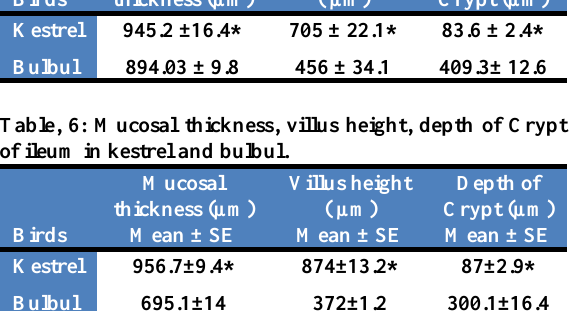
Table, 3: Mucosal thickness, villus height, depth of Crypt of duodenum in kestrel and bulbul. Depth of Figure, 5: Section of villus (kestrel). Micrograph (A) shows: Goblet cells (G), lamina propria (P), Nucleus of epithelial cells (Black arrow), and nuclus of fibrocyte (Red arrow). H&E stain, 400X. Micrograph (B) shows: Goblet cells (G), Red blood cells (RBCs), Nuclus (N), and brush border (arrows). H and E stain. 1000X. Table, 4: Ratio of goblet cells number pear 100 epithelial cells in villus in duodenum, jejunum, ileum of kestrel and bulbul. Birds Bulbul % Kestrel % Intestinal segment 28% 24% Duodenum 41% 28% Jejunum 50% 47% Ileum The numbers represent the mean ± standard error. *= There was a statistically significant difference between the two bird (P = <0.01). Table, 5: Mucosal thickness, villus height, depth of Crypt of jejunum in kestrel and bulbul. Figure, 6: Section of duodenum (white eared bulbul) shows: Villus (1), tunica muscularis (2), tunica serosa (3) lamina propria (P) and branches of villi (Red arrows). H and E stain 100X.